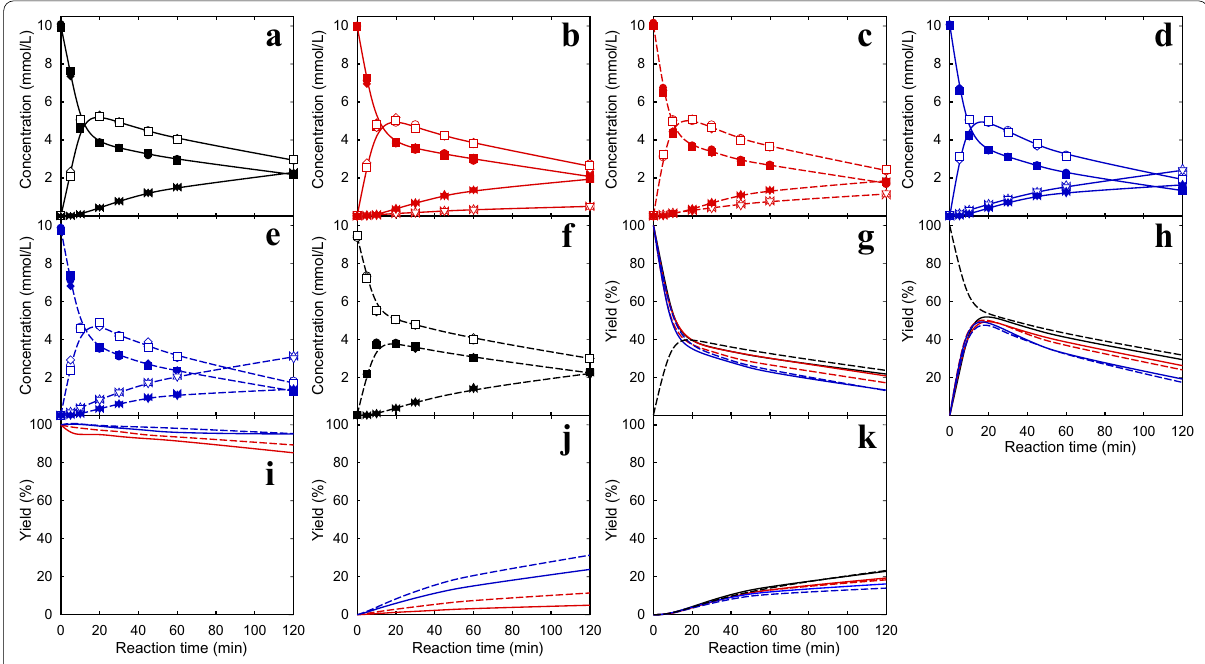
Fig. 6 Time courses of the changes in the concentrations of Ap (filled circles, filled diamonds, and filled squares), Vg (open circles, open diamonds, and open squares), ApCr (open bow-tie-shaped marks, open triangles, and open inverted triangles), and ApVg (filled bow-tie-shaped marks, filled triangles, and filled inverted triangles) in systems Cr0’: a (solid black lines), Cr10’: b (solid red lines), Cr25’: c (dotted red lines), Cr50’: d (solid blue lines), Cr75’: e (dotted blue lines), and Vg: f (dotted black lines), and in the yields of Ap : g , Vg : h , Cr : i , ApCr : j , and ApVg : k in all the systems. Filled circles, open circles, open bow-tie-shaped marks, and filled bow-tie-shaped marks show the 1st trials. Filled diamonds, open diamonds, open triangles, and filled triangles show the 2nd trials. Filled squares, open squares, open inverted triangles, and filled inverted triangles show the